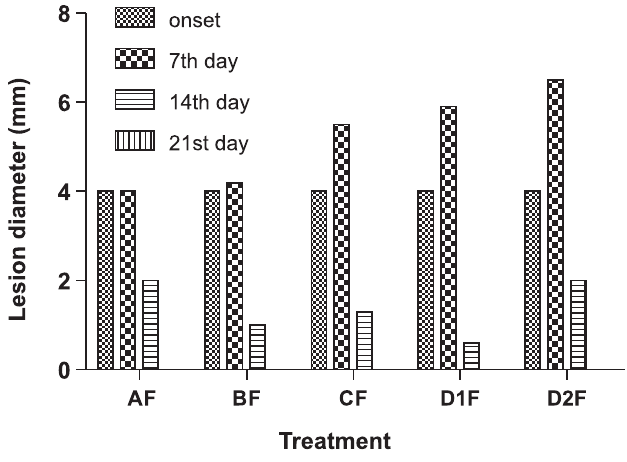
FIGURE 2 - Diameter of skin wounds in animals at the start of treatment and after 7, 14 and 21 days. Key: AF: physiological serum; BF: collagenase; CF: natural palygorskite; D1F: organophilic palygorskite with alkyldimethylbenzylammonium chloride; D2F: organophilic palygorskite with alkyldimethylbenzylammonium chloride.